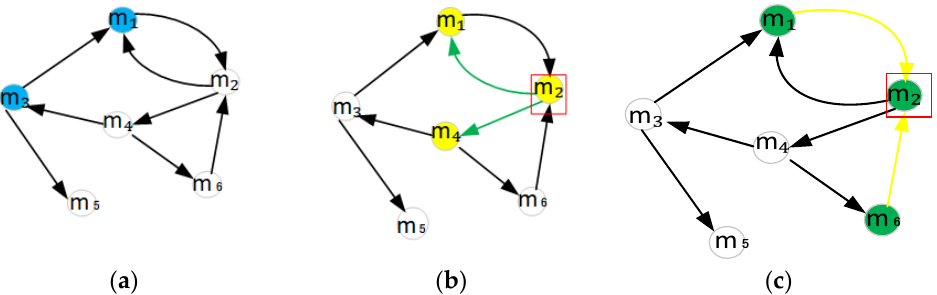
Figure 5. Proximity nodes representation graph. ( a ) First-order proximity; ( b ) In degree proximity; and ( c ) Out degree proximity.